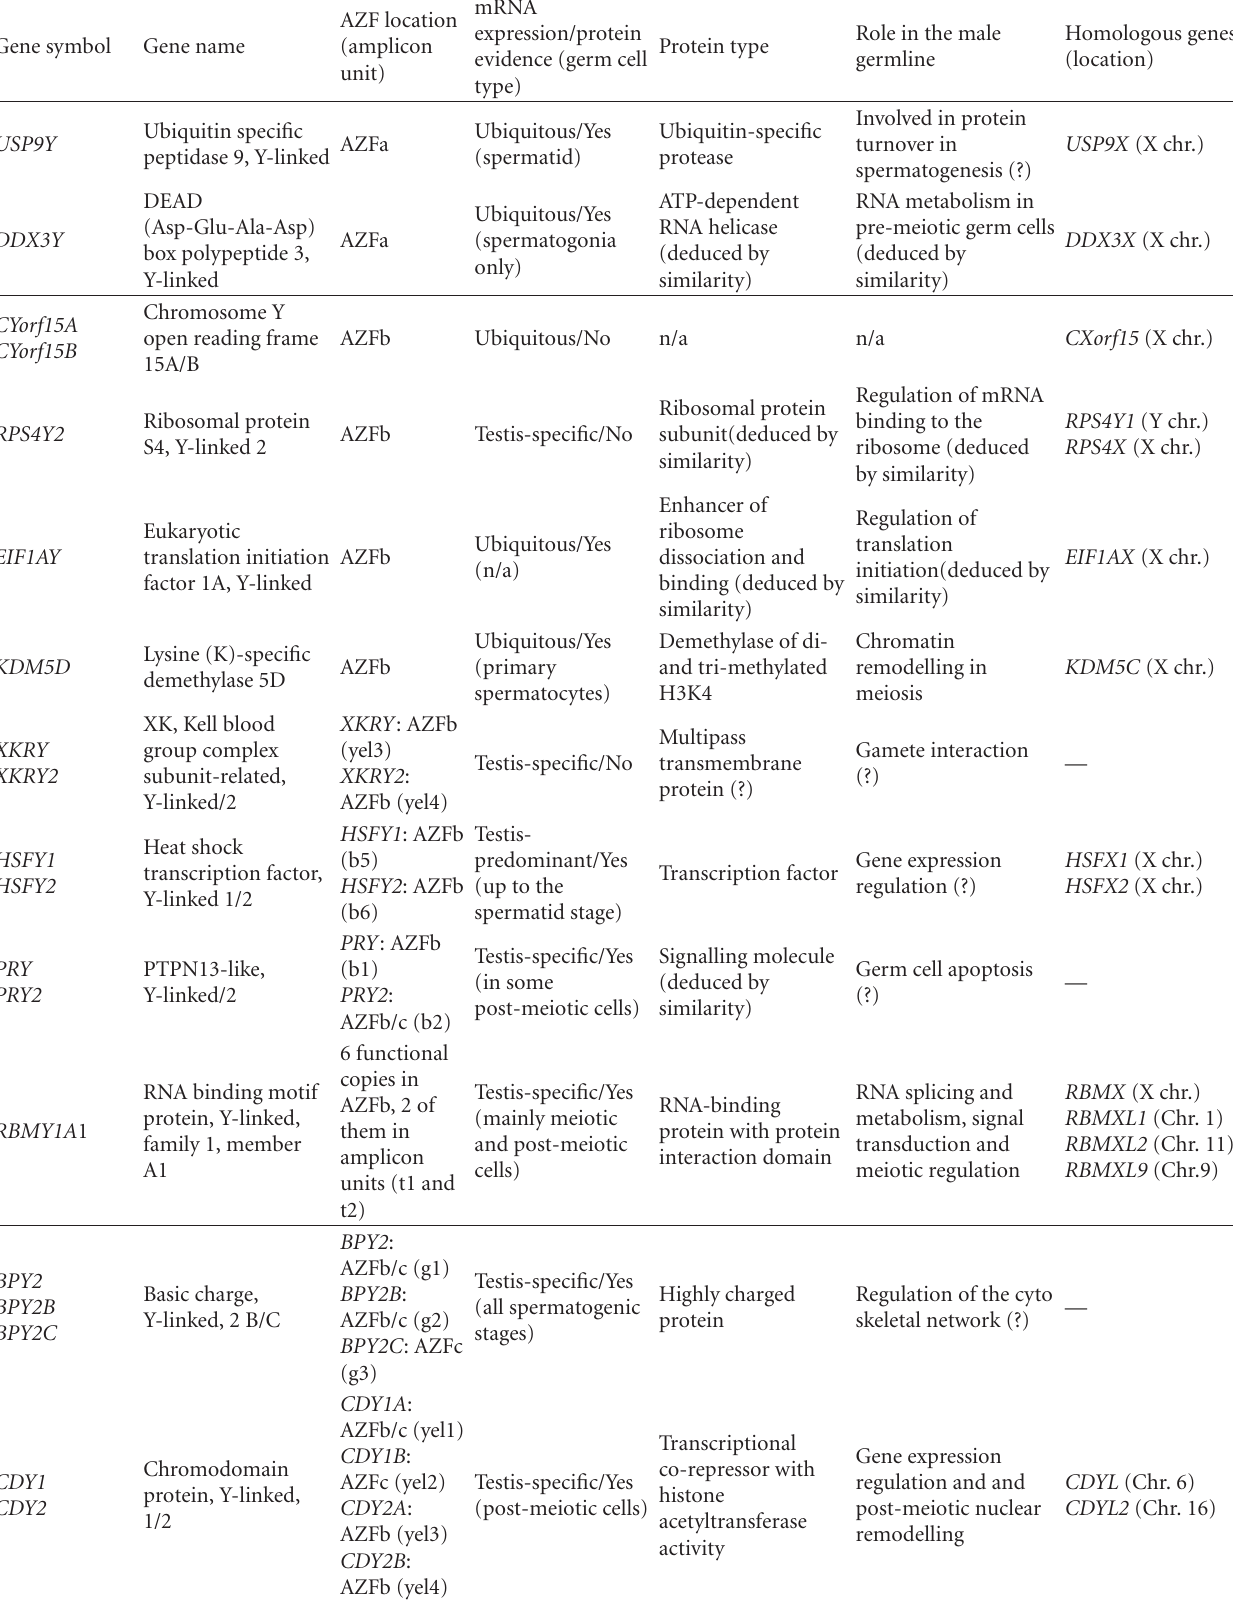
Table 1: Functional and genomic characterization of the AZF